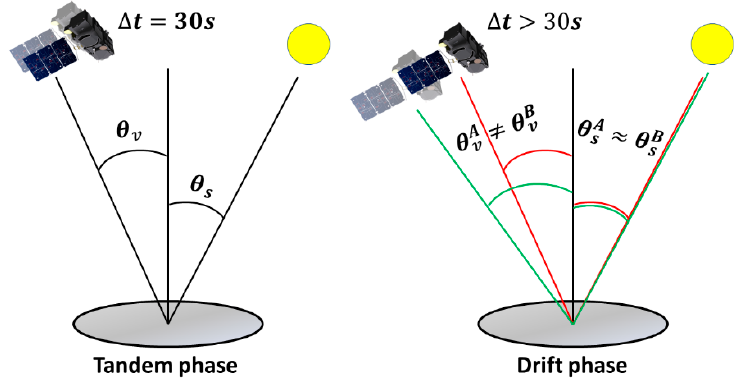
Figure 14. Geometric acquisition differences during the tandem ( left ) and post-tandem drift phase ( right ). While the geometric conditions are almost identical for both satellites during the tandem phase, the sensor acquire the same target with significantly different viewing conditions during the drift phase.